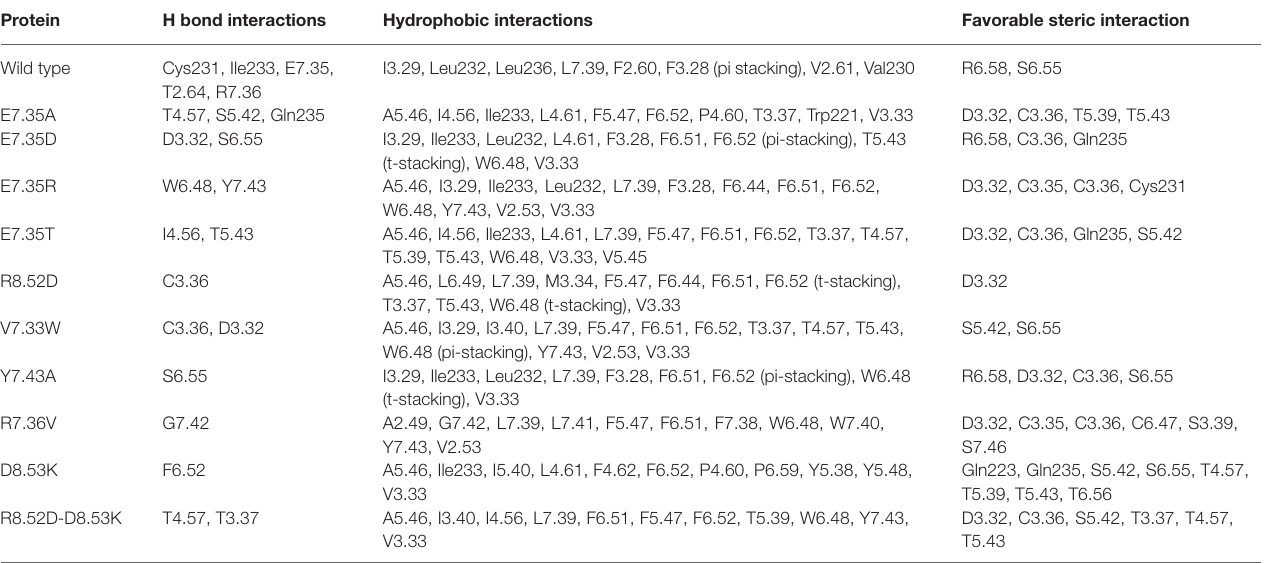
TABLE 2 | List of favorable and unfavorable interactions after docking between SB269970 and the target molecules .